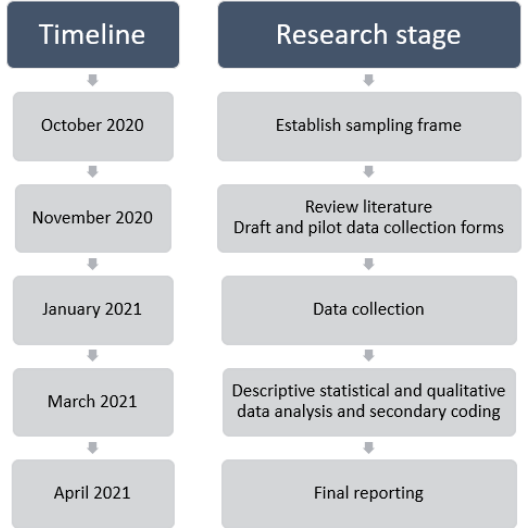
Figure 1. Summary research timeline and stages.